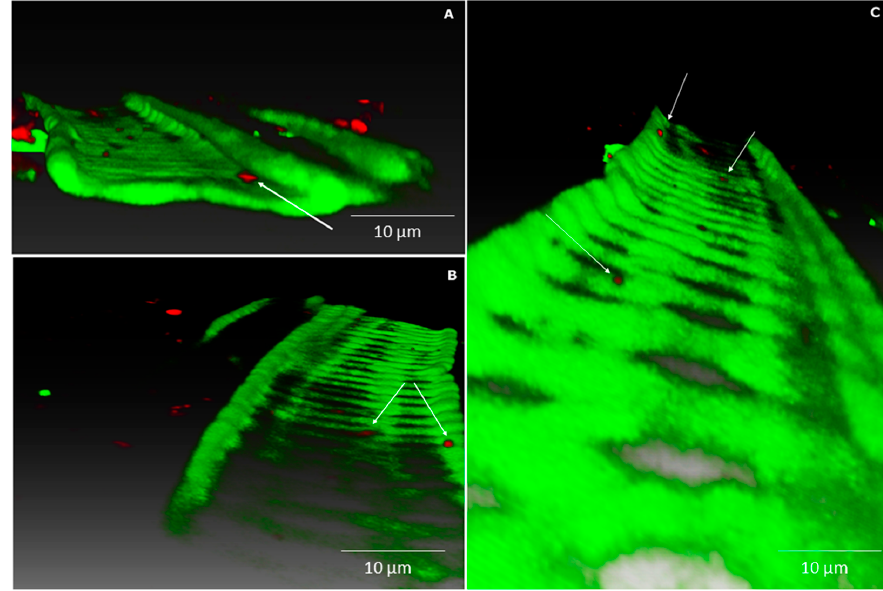
Figure 5. Confocal images with combined mCherry fluorescence (red) and plant autofluorescence (green). Volume rendering ( A – C ) of Methylobacterium sp. Cp3-mCherry colonising the xylem vessels in the stem of Crotalaria pumila growing in medium supplemented with Zn and Cd. White arrows indicate strain Cp3. Confocal stack has a thickness of 54 μ m, acquired with a Ultra VIEW VoX (PerkinElmer) using the CFI Plan Fluor objective 40.0 × 0.75. Z-step was 1 μ m. Three-dimensional models were created with the software Amira 6.0.1 (FEI software, Hillsboro, OR, USA).